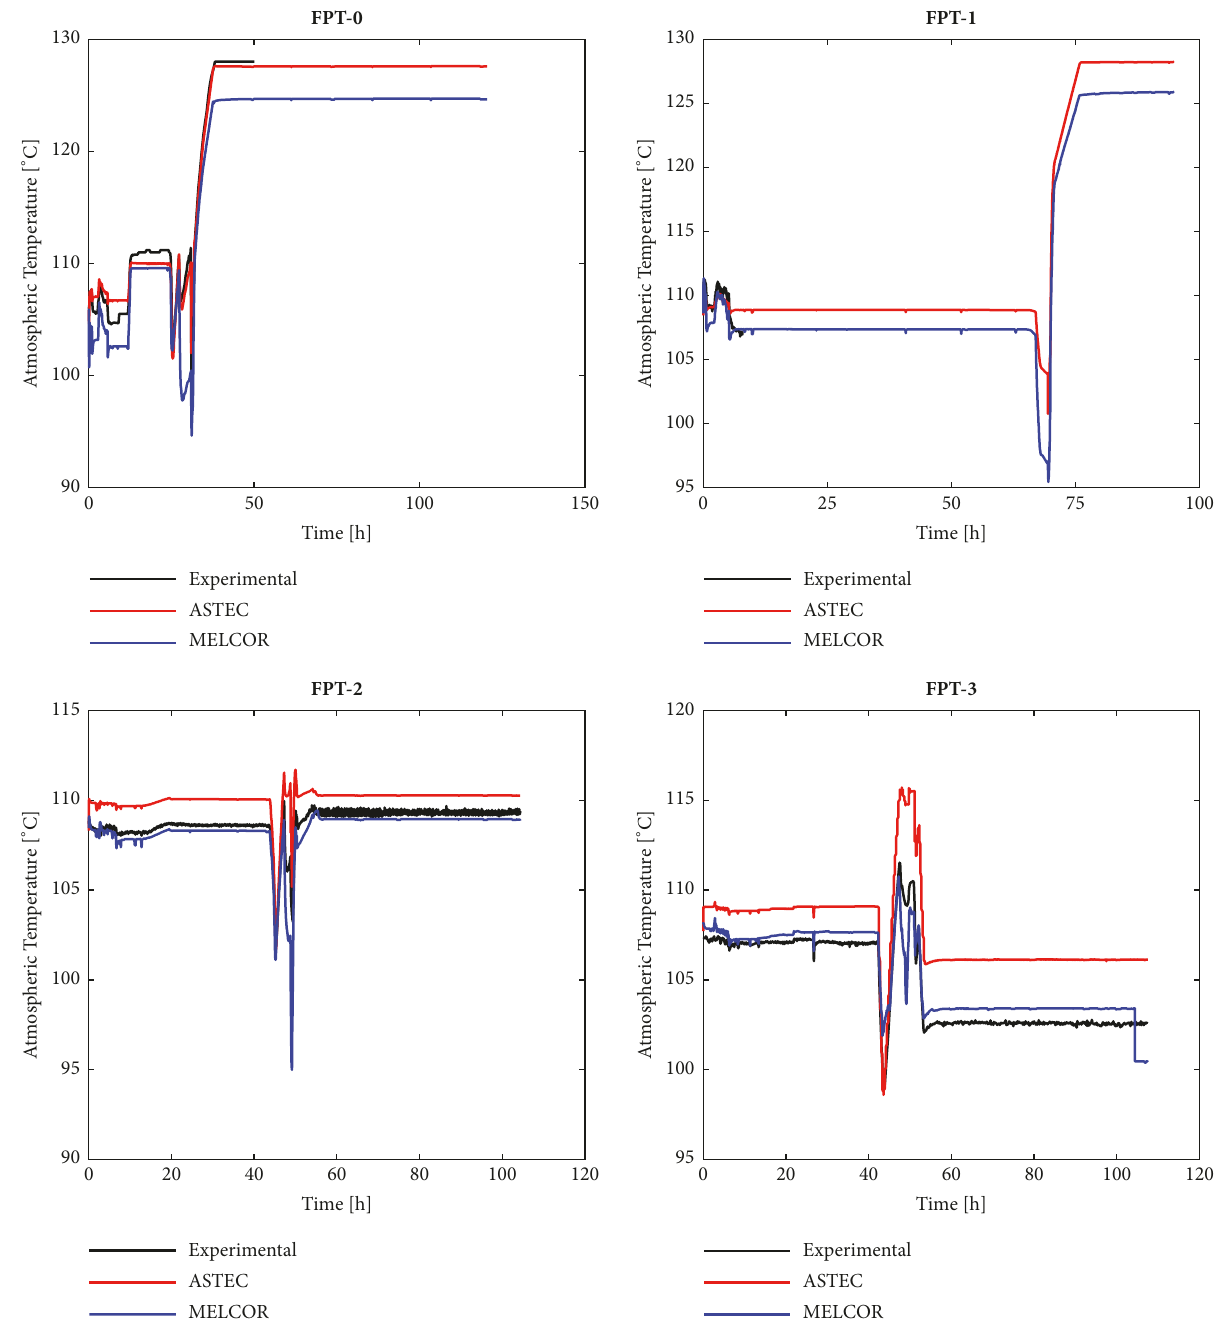
Figure 7: Mean atmospheric temperature evolution during the Ph´ebus FPT